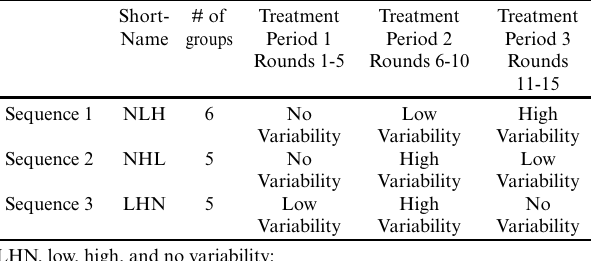
Table 1 . Treatment